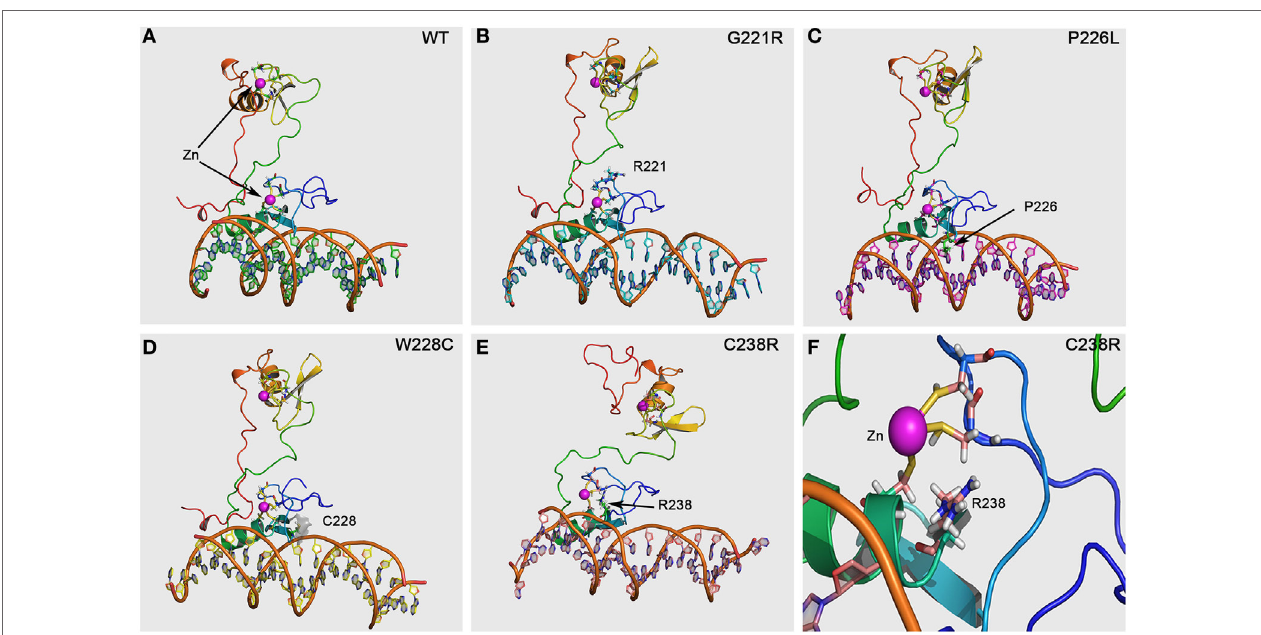
FigUre 4 | GATA4 protein model and prediction of effects by mutations. The GATA4 protein model was made using the structures of GATA1 and GATA3 available in the protein structure database. After performing a structure-based search using Phi-BLAST, two different structures of GATA1 and GATA3 were selected and used for model building as described in Section “Materials and Methods.” (a) Structural of WT GATA4 showing the Zn coordination and binding to DNA. (B) The Gly221Arg mutation is predicted to cause disruption of Zn binding and protein instability, resulting in a loss of function mutation. (c) The mutation Pro226Leu is in the nucleotide interaction interface and was predicted to alter the recognition of promoter sequences for binding to GATA4. This can lead to variable effects with some promoters showing on effect while other could be affected. (D) The mutation Trp228Cys was also predicted to cause variable effects due to its proximity to DNA-binding interface of GATA4. Inclusion of extra cysteine was not predicted to cause the disruption of Zn binding as Cys228 in the mutant was far away from the Zn binding site. (e) The mutation Cys238Arg was predicted to cause loss of Zn binding, leading to an instable and non-functional GATA4 protein. (F) A close-up of the Cys238Arg mutation showing the loss of Zn coordination to cysteine due to introduction of the arginine, which could not bind the Zn molecule to stabilize the protein. A severe loss of function effect was predicted for the Cys238Arg